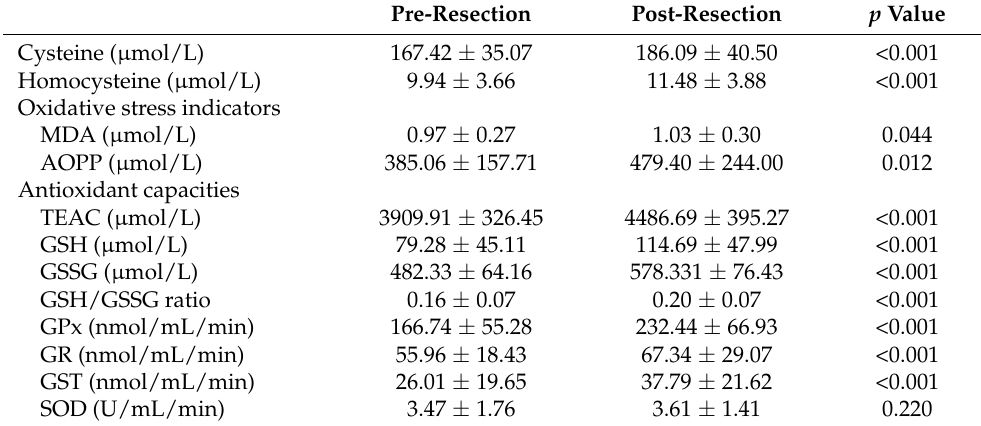
Table 2. Plasma cysteine, homocysteine, indicators of oxidative stress, and antioxidant capacities in patients with colorectal cancer.